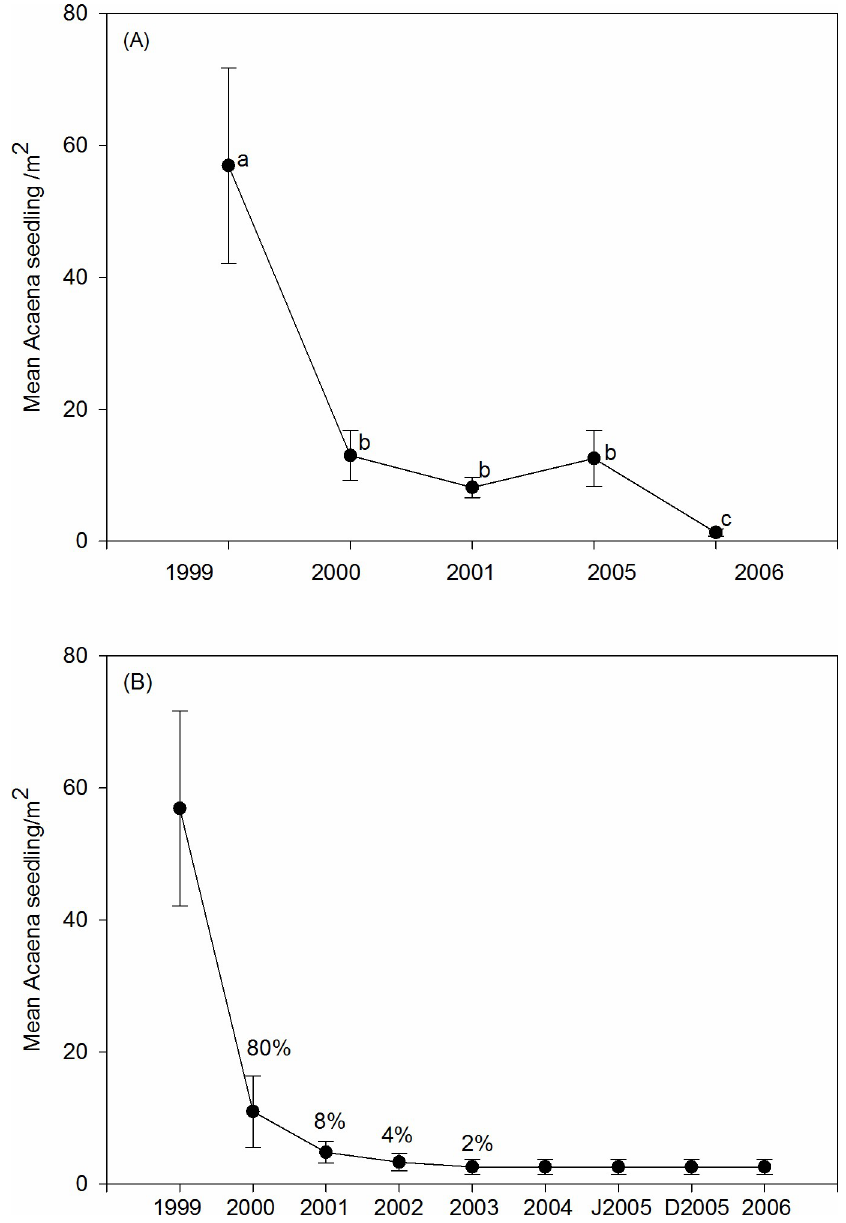
Fig 4. Acaena splendens seedling emergence and mortality. Mean seedling.m -2 of A . splendens (A) emerged from 1999 to 2006, (B) from the cohort that emerged in 1999 and was monitored until 2006. We indicated percentage mortality on each sampling